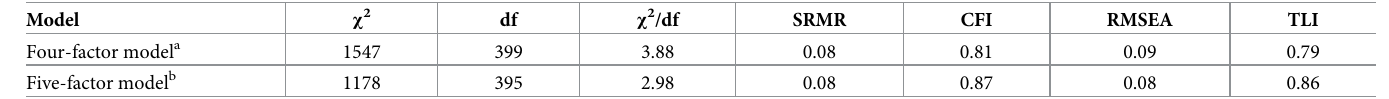
Table 3. Confirmatory factor